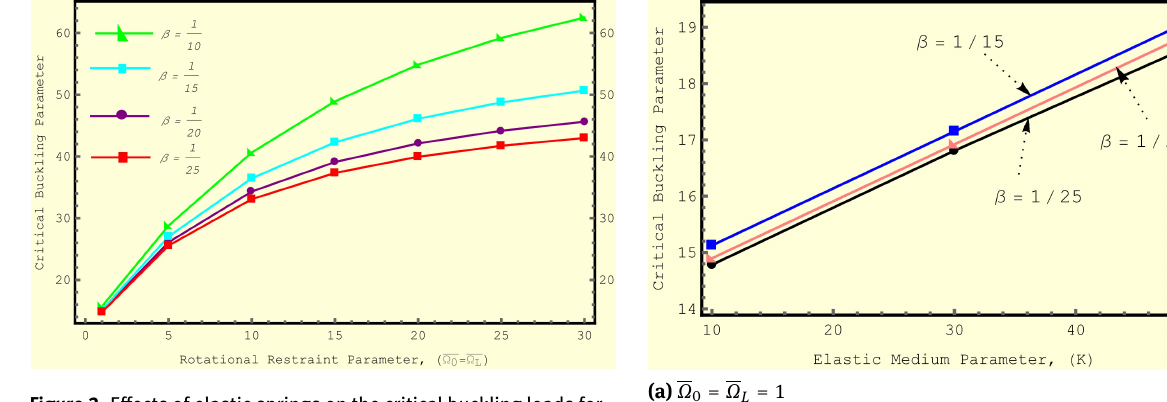
Figure 2: Effects of elastic springs on the critical buckling loads for different small scale parameter with K = 10